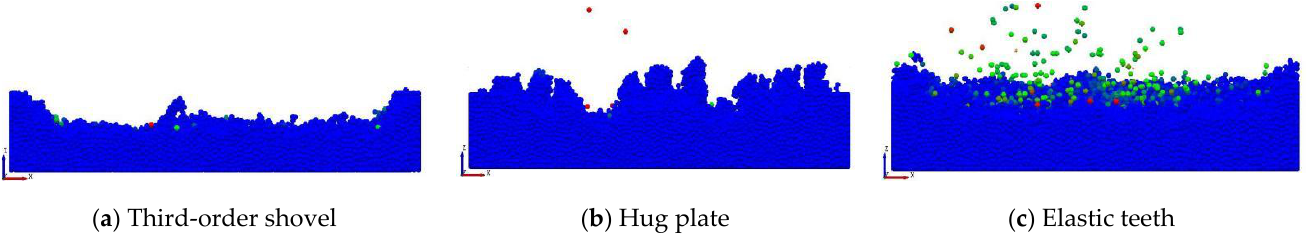
Figure 12. The ridge body state after simulation of different film-lifting parts. The large and small ridges were cut, the ridge soil was moved forward, and the seed bed was relatively flat after the operation of the third-order shovel film-lifting parts, as shown in Figure 12a. The ridge body retains the approximate shape of double ridges after the hug plate film-lifting parts were operated, as shown in Figure 12b, and the amount of soil depolymerization of the ridge body was small. Following the operation of the elastic teeth film-lifting parts, as shown in Figure 12c, the ridge and ditch were filled with a large amount of soil particles after depolymerization, and the seed bed was relatively